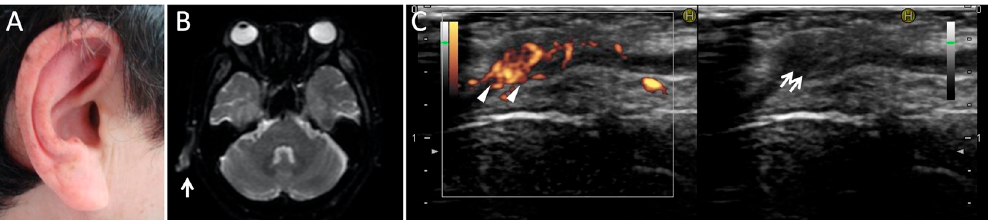
Figure 7. Magnetic resonance imaging and ultrasonography of auricular chondritis in a patient with optic perineuritis due to RPC. The right pinna is red and swollen ( A ) and diffusion-weighted magnetic resonance imaging ( B ) shows signal hyperintensity of the right auricle (arrow). Ultrasonography ( C ) reveals a high-power Doppler signal surrounding the cartilage (arrowheads) and swollen auricular cartilage (arrows).